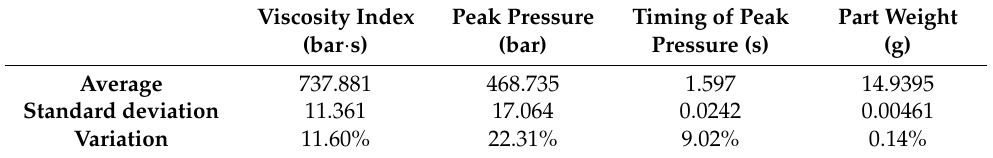
Table 5. Analysis results of pressure curve characteristics and part weight with adaptive control